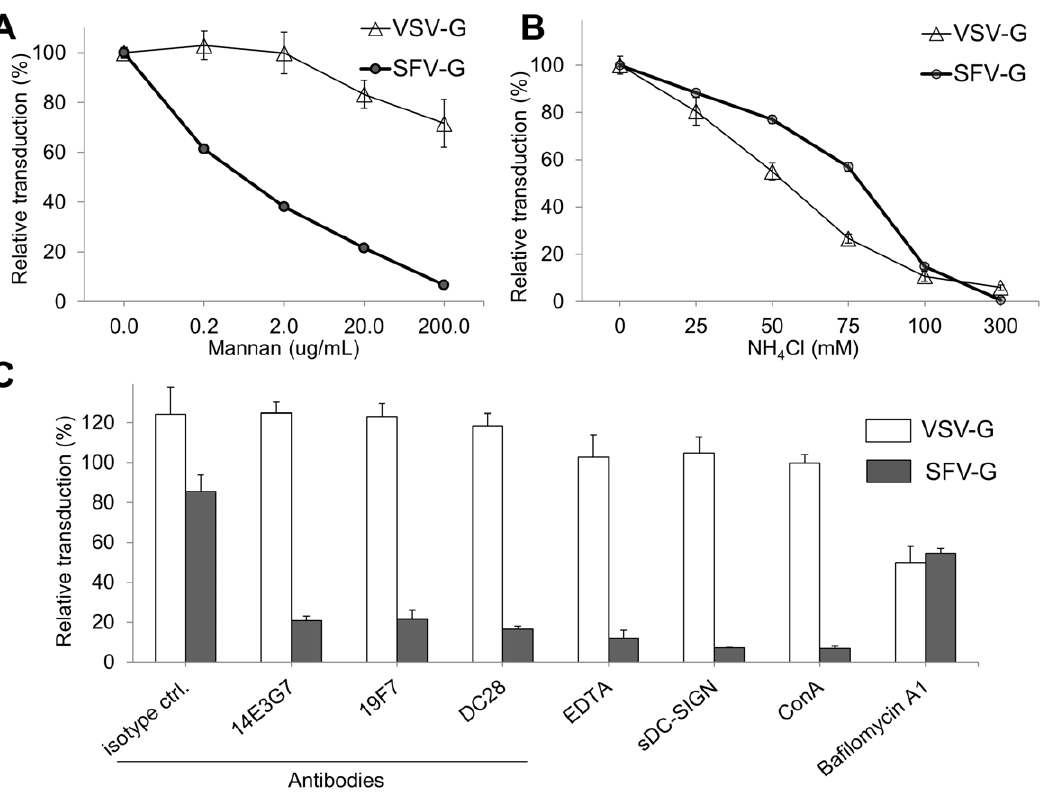
Figure 4. Specific inhibitors prevent DC-SIGN-mediated infection. In dose-response experiments, 293T.DCSIGN cells were treated with SFV-G (solid circles) or VSV-G (open triangles) lentiviruses in the presence of increasing concentrations of mannan (A), or NH 4 Cl (B). (C) 293T.DCSIGN cells were incubated with antibodies at a concentration of 5 m g/ml, 15 nM Bafilomycin A 1 , 5 mM EDTA, or 10 m g/ml soluble DC-SIGN at 37 u C for 30 min, and then inoculated with SFV-G (filled bars) or VSV-G (open bars) lentiviruses at an MOI , 0.8 for 8 hrs or lentiviruses incubated with 25 m g/mL ConA (1 h at 37 u C). Subsequently, the supernatants were replaced and incubated with fresh medium for two days before being analyzed for GFP expression. The relative transduction was determined based on non-treated controls and values are given as the mean of triplicates 6